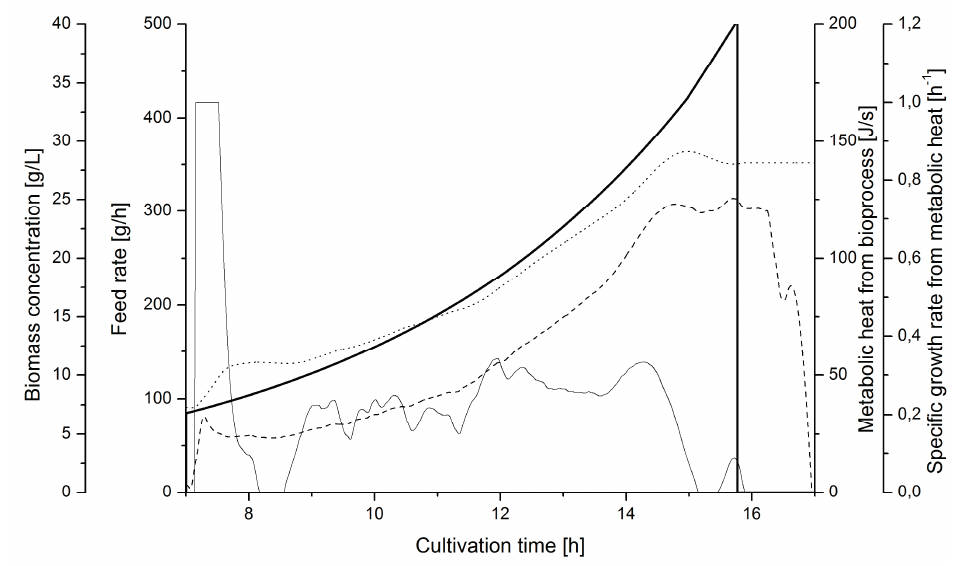
Figure 8. Uncontrolled fed-batch cultivation. Pre-set feed rate ( ), metabolic heat production ( ), estimated µ metabol from the soft sensor (